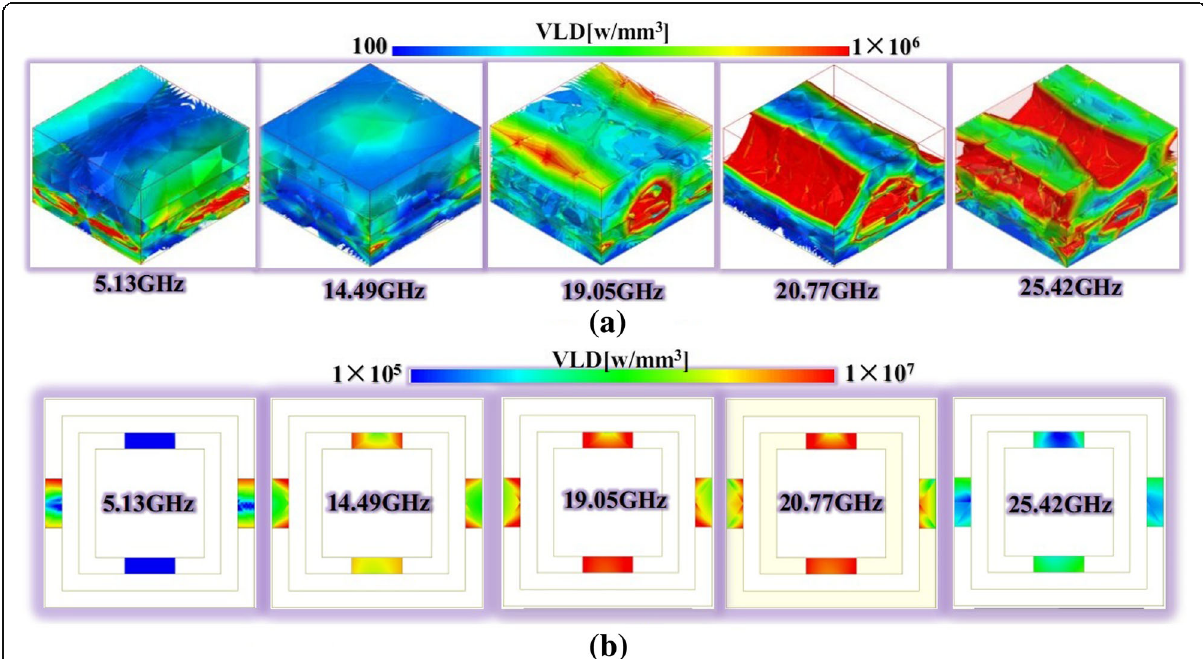
Fig. 7 The dielectric and ohmic losses of the substrates and the lumped resistances for the proposed PAM at 5.13, 14.49, 19.05, 20.77, and 25.42GHz. a The